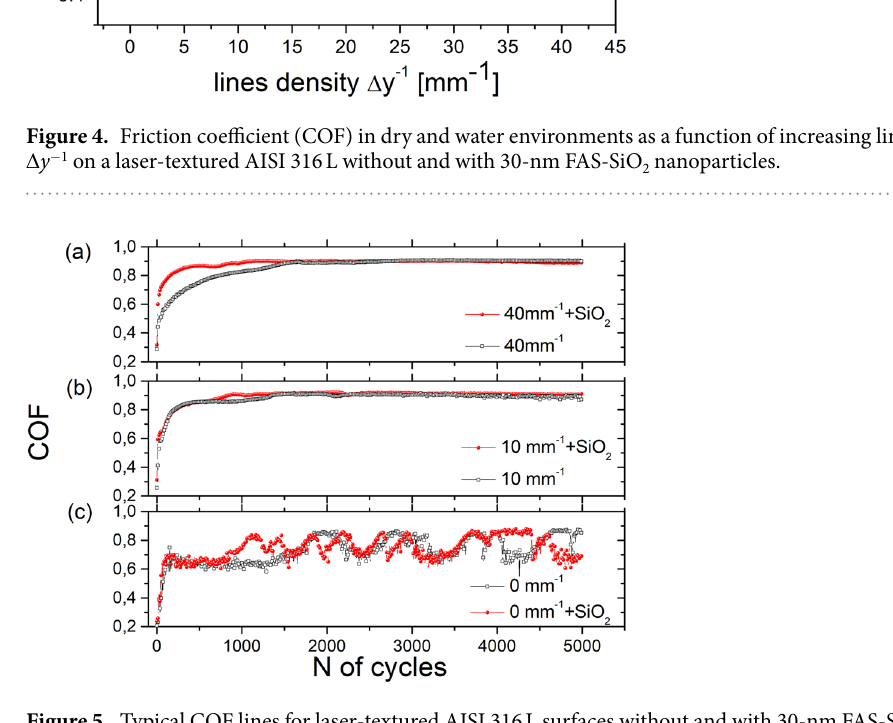
Figure 5. Typical COF lines for laser-textured AISI 316 L surfaces without and with 30-nm FAS-SiO 2 nanoparticles in a dry environment. A clear difference in the running-in behaviour after adding nanoparticles is visible for samples with high Δ y − 1 ( a ), and no difference is observed for samples with low Δ y − 1 ( b ). For unprocessed samples ( c ), oscillations in the COF